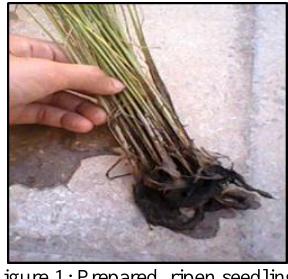
Figure 1: Prepared ripen seedlings